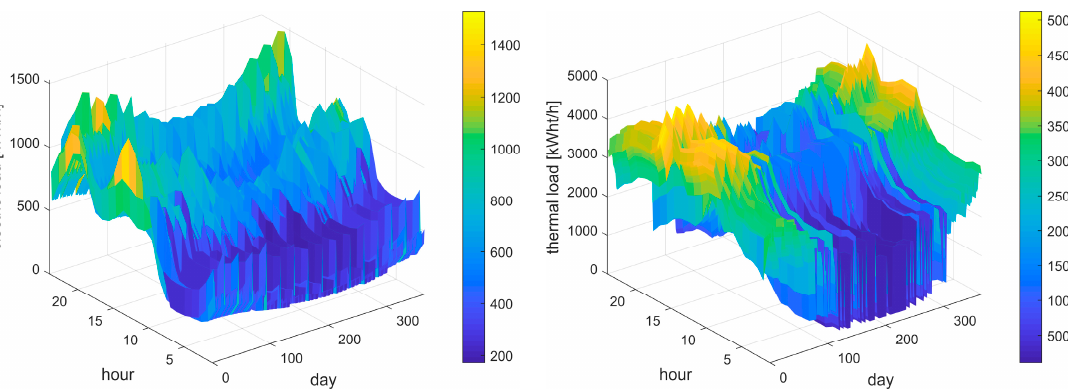
Figure 2. Annual electric ( left ) and thermal ( right ) load profile.